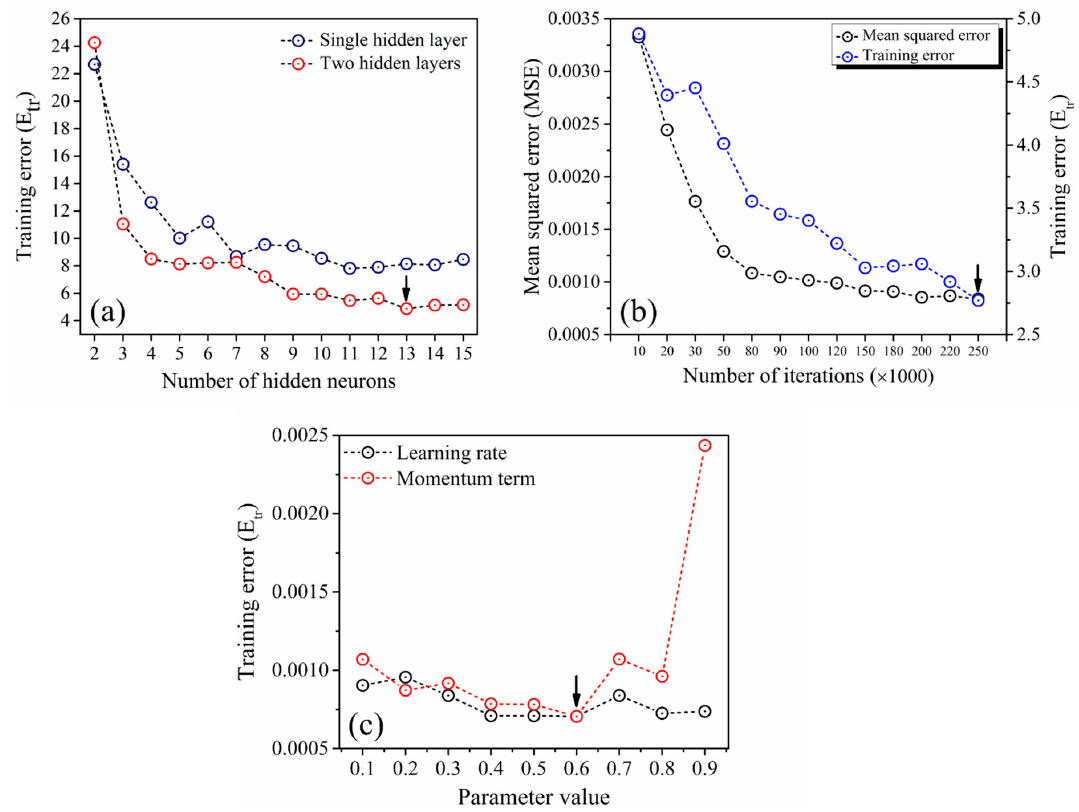
Figure 2. Change in output error a function of ( a ) hidden layers and neurons, ( b ) iterations and ( c ) learning rate and momentum term, respectively.